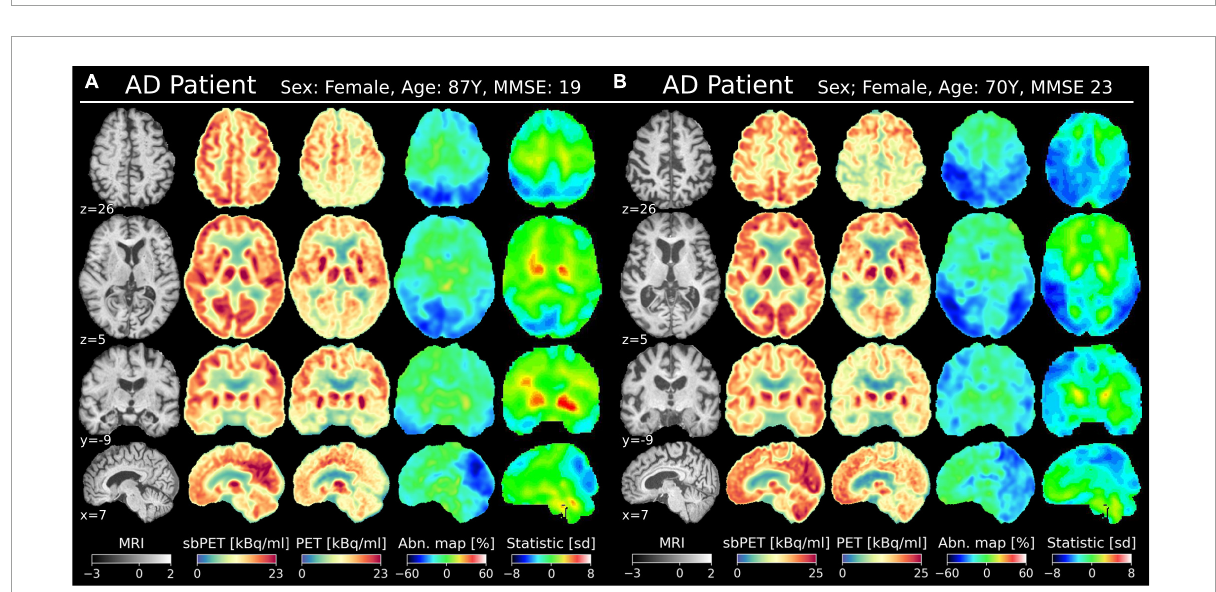
FIGURE7 Two AD subjects in MNI space (affine transformation); one with minimal atrophy (A) and one with substantial atrophy (B) . The MNI coordinate is denoted for each view. Columns from the left: T1w MRI (normalized intensity), sbPET (post-normalized), true PET, abnormality map, vendor-provided statistical